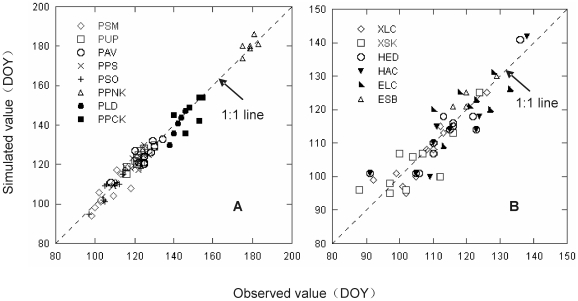
Observed versus simulated values for tree (A) and herb (B) leafing in Northeast China based on Temperature-precipitation based leafing model (TPn).Tree species include PSM=Salix matsudana; PUP=Ulmus pumila; PAV=Armeniaca vulgaris; PPS=Populus simonii; PSO=Syringa oblate; PPNK=Pinus koraiensis; PLD=Larix dahurica; and PPCK=Picea koraiensis. Herbs include XLC=Leymus chinensis in Xilinhot; XSK=Stipa krylovii; HED=Elymus dahuricus; HAC=Agropyron cristatum; ELC=Leymus chinensis in Ewenki; and ESB=Stipa baicalensis.